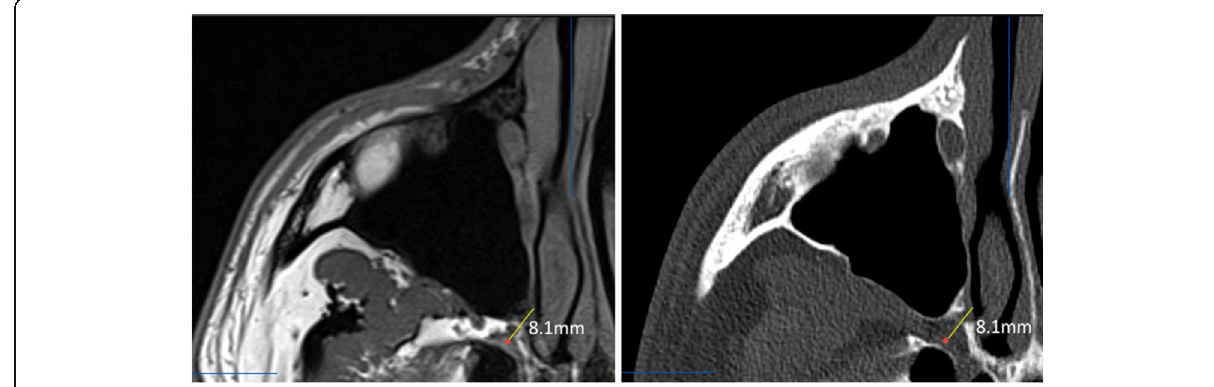
Fig. 1 Axial images through the SPG in one of the patients. Left: T1 weighted MRI. Right: CT scan. Both images show the same anatomical plane. The SPG (red dot) is first localized in the MRI scan and the closest point of the nasal mucosa through the SPF is localized in fusioned CT images. In this example, the distance was 8.1 mm (yellow line). Notice the typical crescent form of the SPG anterior to the opening of the Vidian